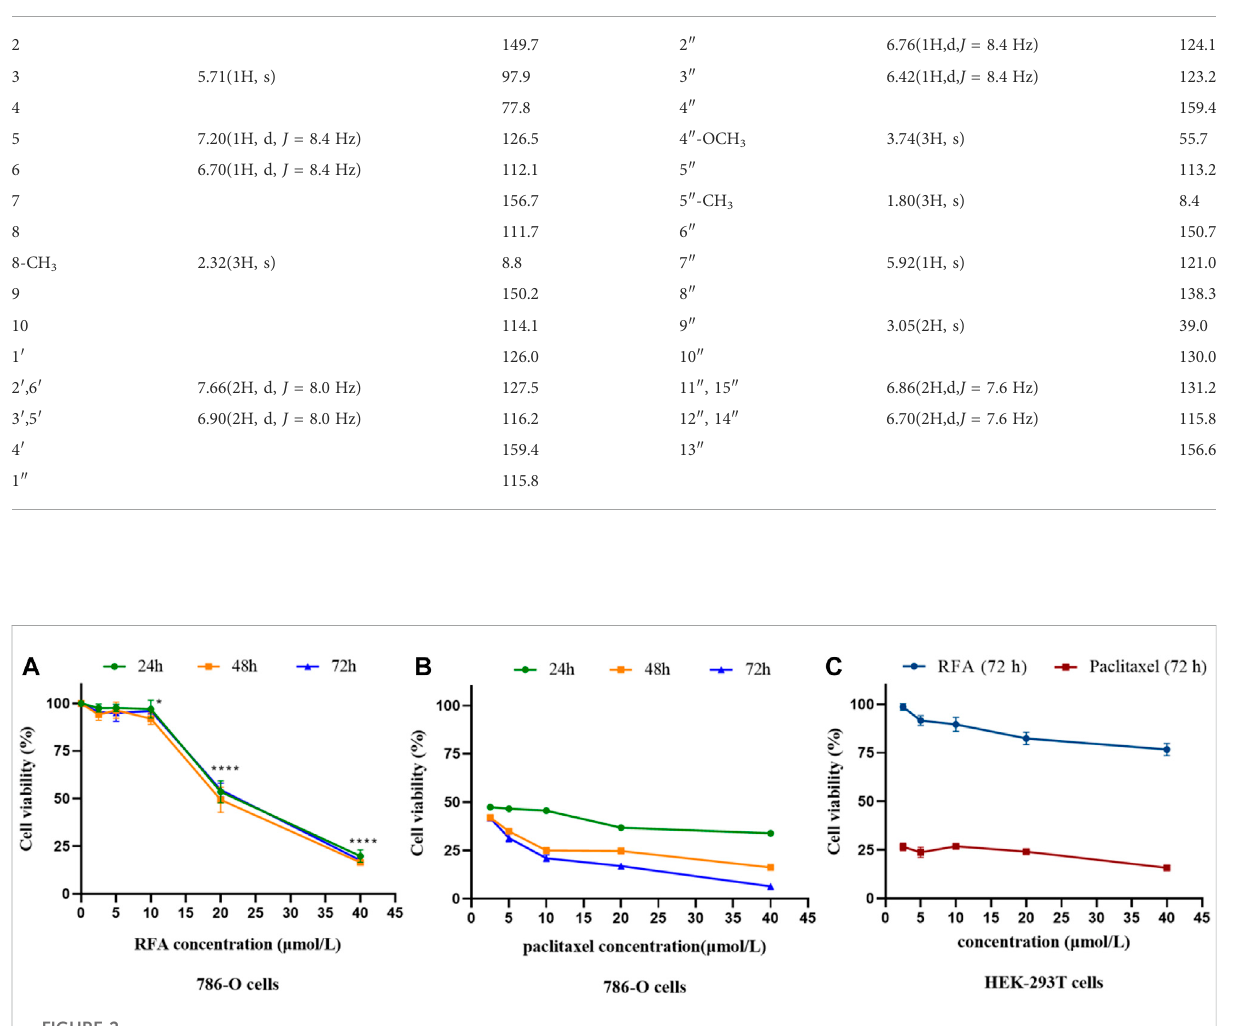
FIGURE 2 (A,B) The cell viability of 786-O cells under thetreatmentof RFA and paclitaxel at the different concentrations for 24, 48, and 72 h, respectively. (C) The cell viability of HEK-293T cells under the treatment of RFA and paclitaxel at different concentrations for 72 h, respectively. Data were expressed as mean ± SD. * p < 0.05, ** p < 0.01, **** p < 0.0001, versus the untreated control